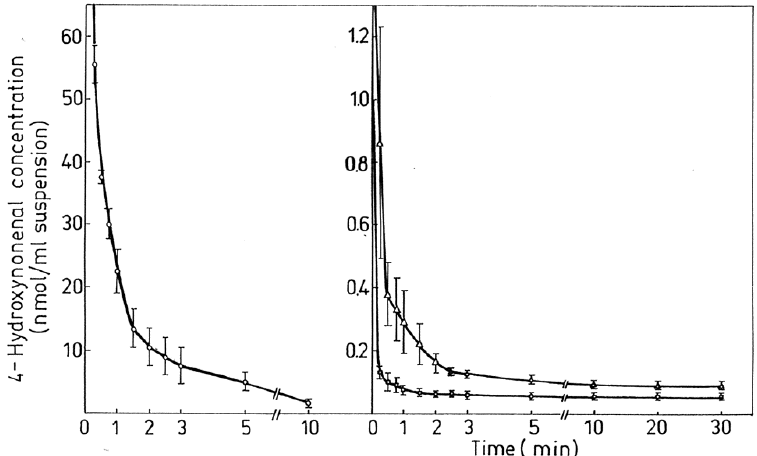
Figure 6. Degradation/metabolism of 4-HNE in rat hepatocytes. The method was the so-called direct measurement of HNE by HPLC . The remaining HNE shown in the graphs is the total of not metabolized HNE within the suspension, i.e. , intracellular plus extracellular ones at the indicated time-points. The differenciation between the intracellular and extracellular compartments of HNE is not necesssary for balancing the HNE degradation/metabolism.